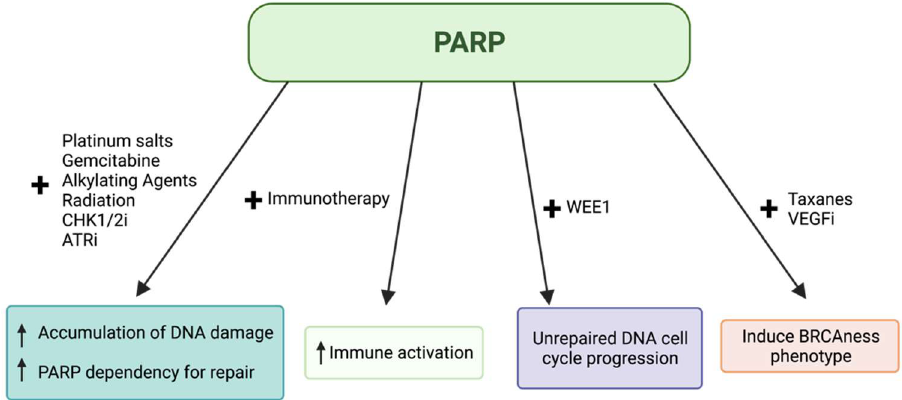
Figure 2. Overview of the mechanisms of PARP inhibitors in combination with other agents.